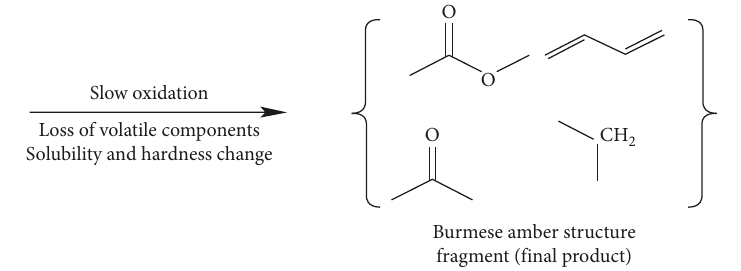
Figure 9: Structural changes involved in the formation of Burmese